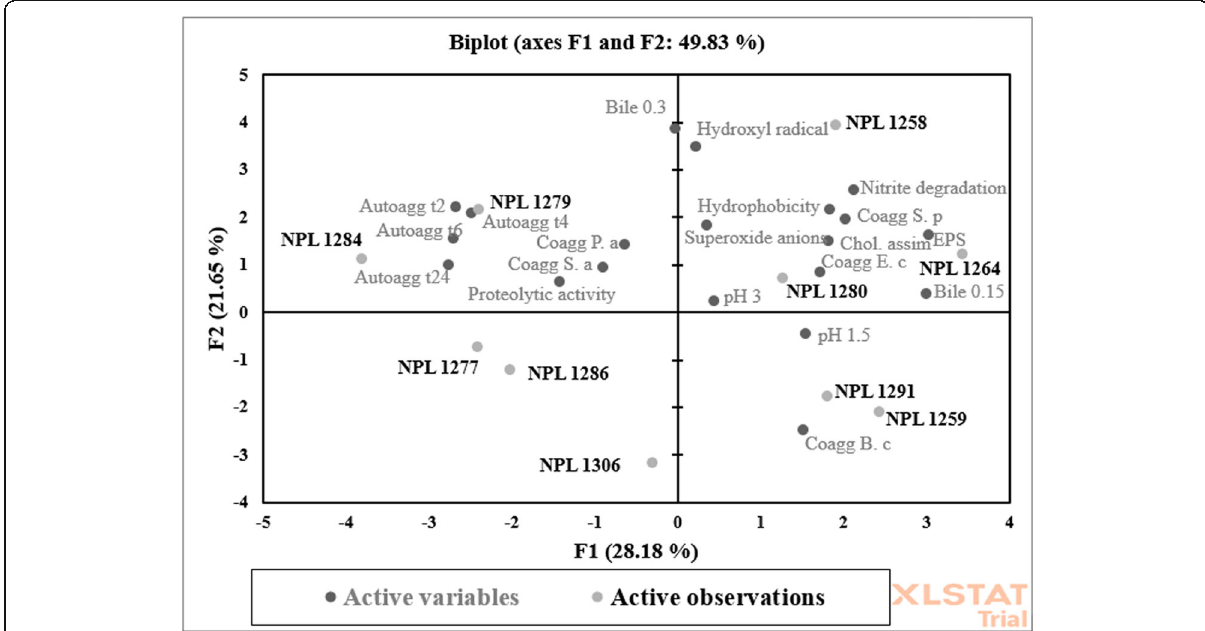
Fig. 4 PCA biplot projecting the probiotic potential starter culture variables and